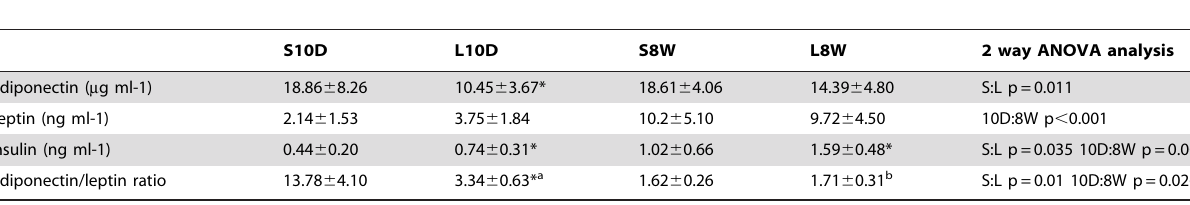
* p , 0.05, Two-way ANOVA Holm Sidak posthoc analysis of significant difference between the lipectomized and the time-matched sham-operated groups. a positively correlated to the level of LDL (r=0.823, p , 0.05) and negatively to glucose and insulin (r= 2 0.821 and 2 0.892 respectively, p , 0.05) as calculated by Pearson Product Moment Correlation. b negatively correlated to insulin (r= 2 0.892, p , 0.05) as calculated by Pearson Product Moment Correlation.